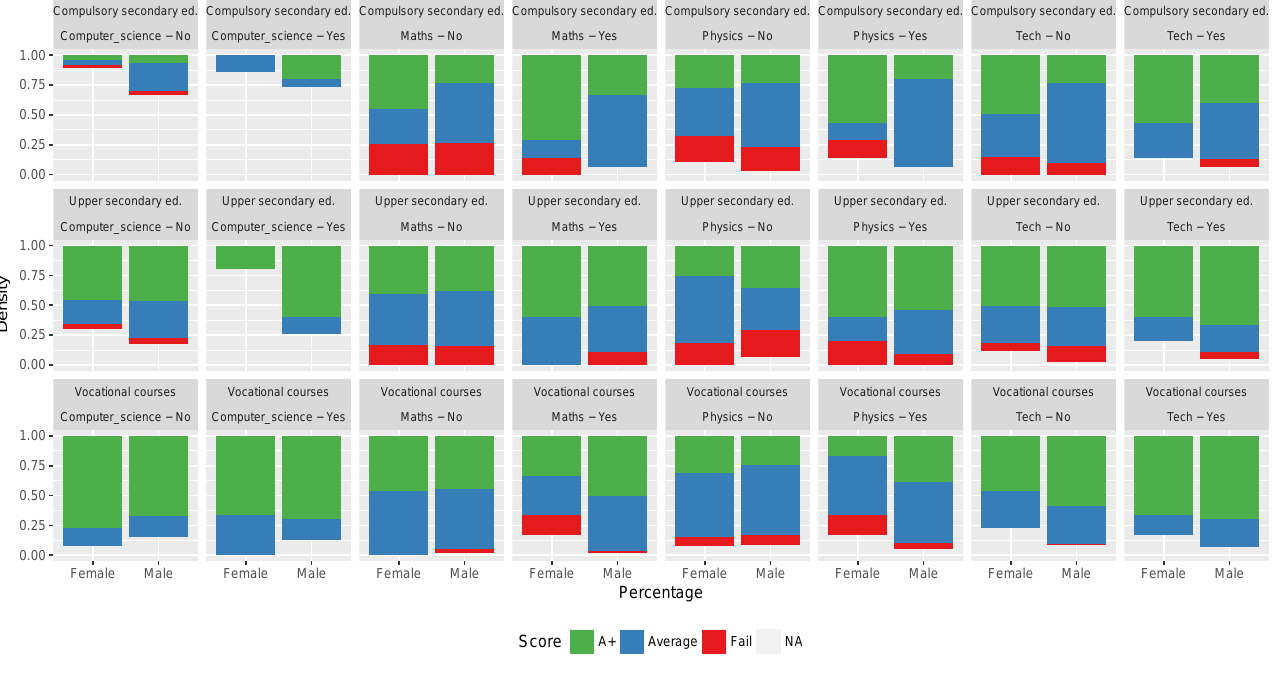
Figure 2. Comparison between what the students reported about their scores in STEM subjects and their plans for studying (or not) engineering. The question was “Do you consider studying an engineering degree?”. Results are detailed per course as well as by gender. Since not all students have enrolled in the computer science course, and others have decided not to report their scoring, we represent these as blanks (NA) because they give valuable information too.